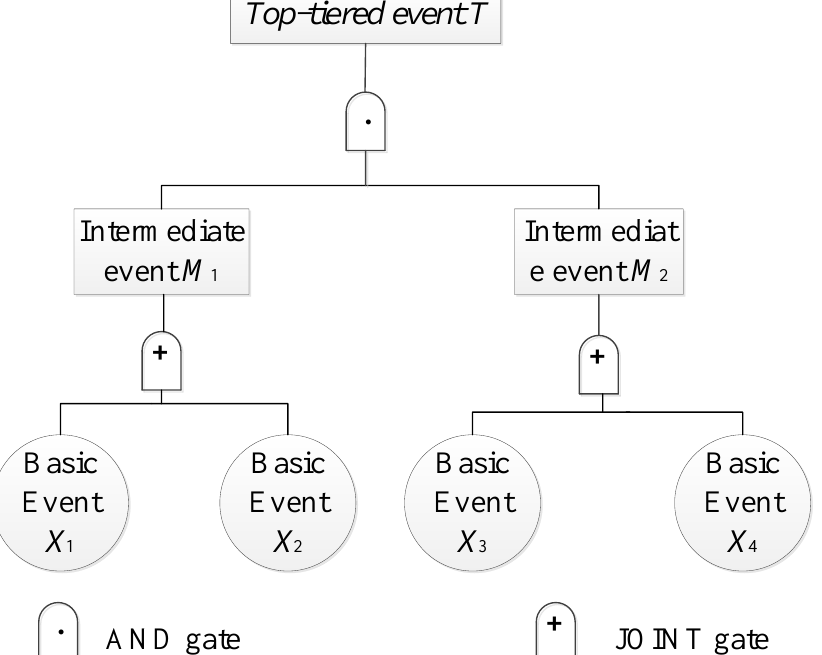
Figure 4. The demonstration of the structure of the fault tree model.